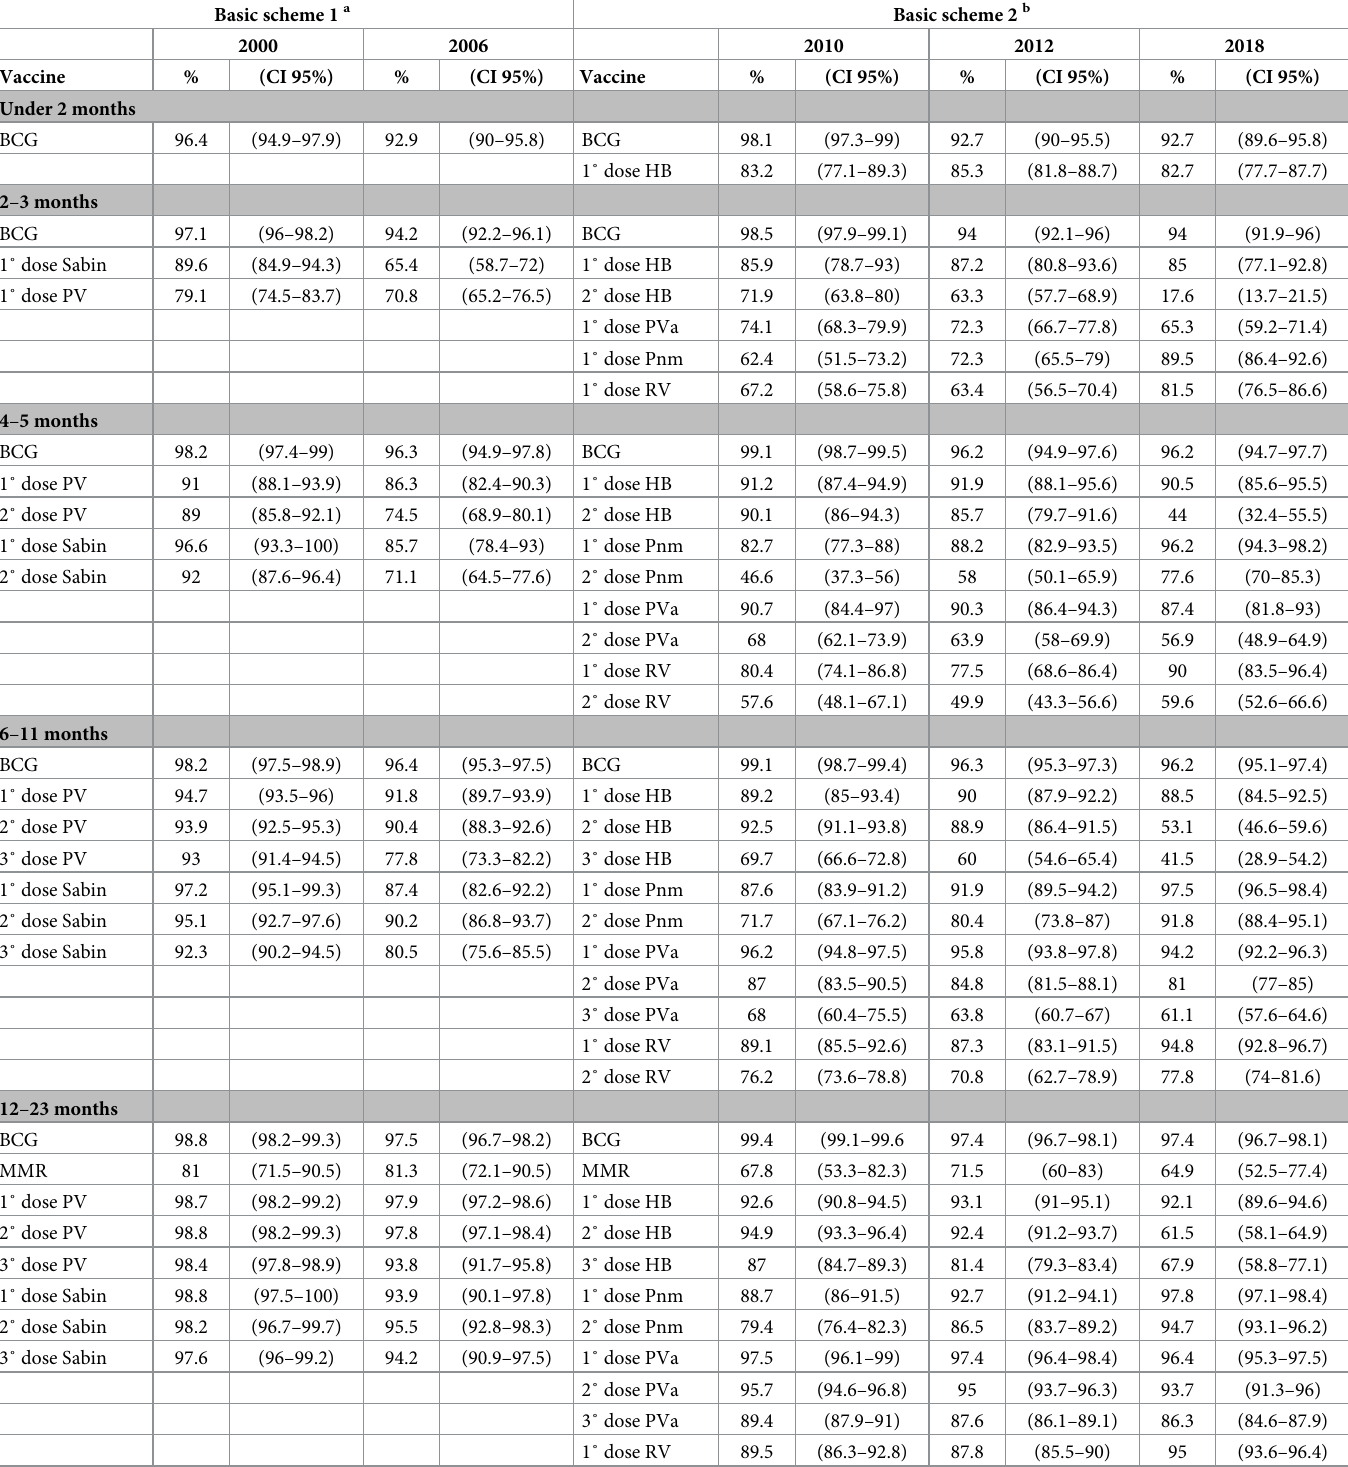
Table 3. Estimated vaccination coverage of two basic schemes according to accumulated doses and age groups, Mexico